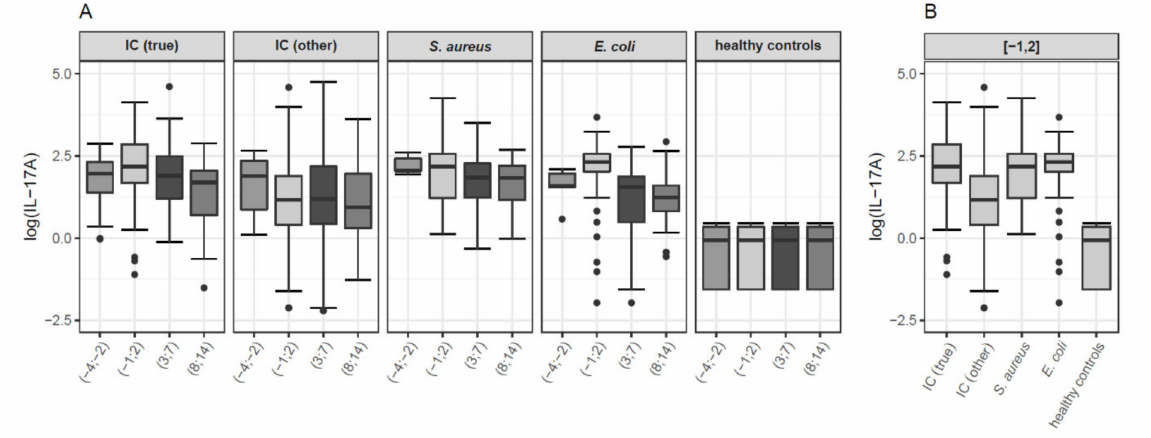
Figure 1. Boxplots of interleukin 17A (IL-17A) values of the investigated study groups for each time interval ( A ), and with focus on time interval ( − 1; 2) ( B ) for the total study population. IL-17A values (pg/mL) are depicted on the logarithmic scale. In the boxplots, median values are depicted as bold line and the box spans from first to third quartile; whiskers extend to a maximum of 1.5 times the interquartile range (IQR, third minus first quartile) out from the respective box end; all remaining values are indicated as dots. Time intervals represent study days. Time interval ( − 1; 2) includes blood samples collected one day prior until up to two days after collection of the index sample. IC = invasive candidiasis.